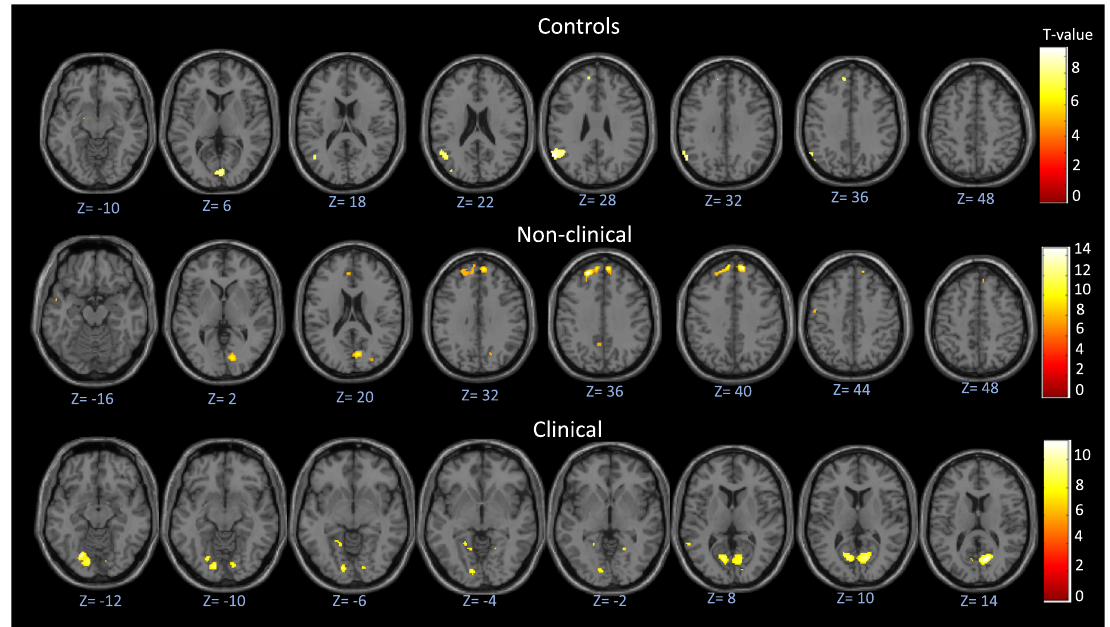
Fig. 1 Activation patterns in each of the three study groups during the Telepath task. Contrast: Think about how this was done > Please rest. Top: signi fi cant activation in controls (N = 16). Middle: signi fi cant activation in the non-clinical group (N = 16). Bottom: signi fi cant activation in the clinical group (N = 16).